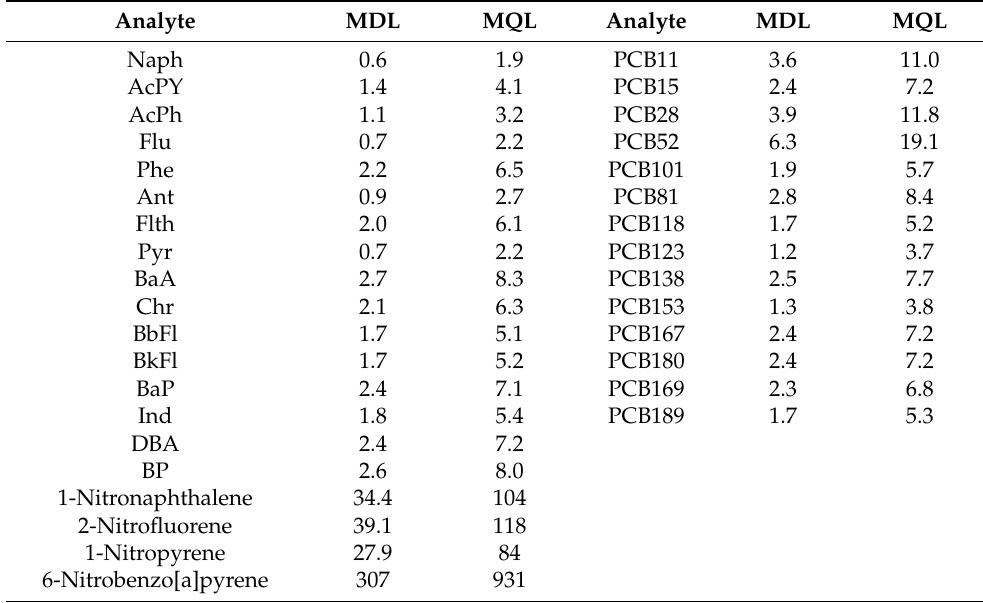
Table 5. Method detection (MDLs) and quantitation (MQLs) limits for the target PAHs, nitro-PAHs and PCBs. Concentrations are expressed in µ